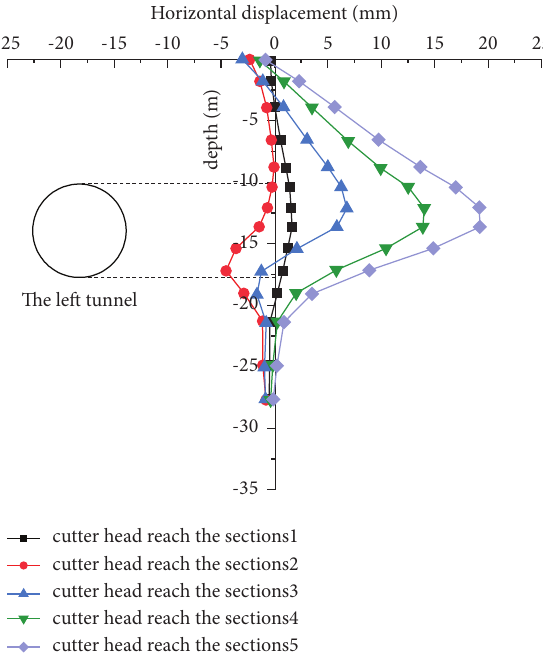
Figure 18: The left tunnel excavation gap is not